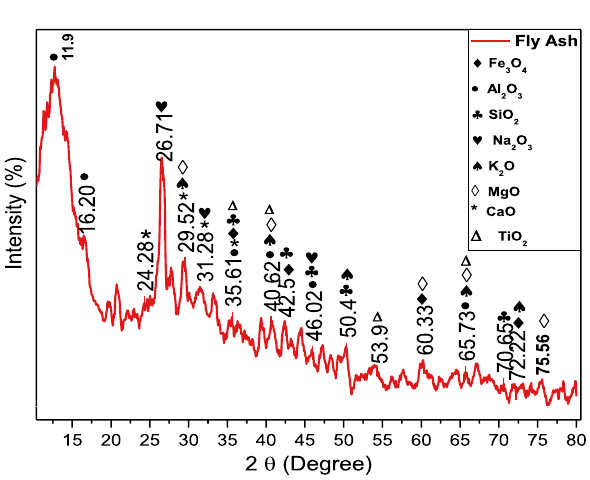
Figure 3. XRD spectrum of fly ash.